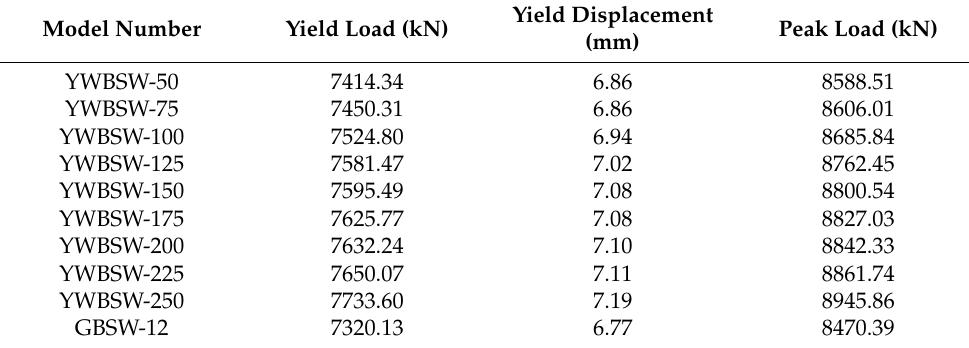
Figure 9. Skeleton curve of models with different lap lengths. ( a ) Lap length 50~150 mm; ( b ) lap length 150~250 mm. Table 9. Mechanical performance of models with different lap lengths.